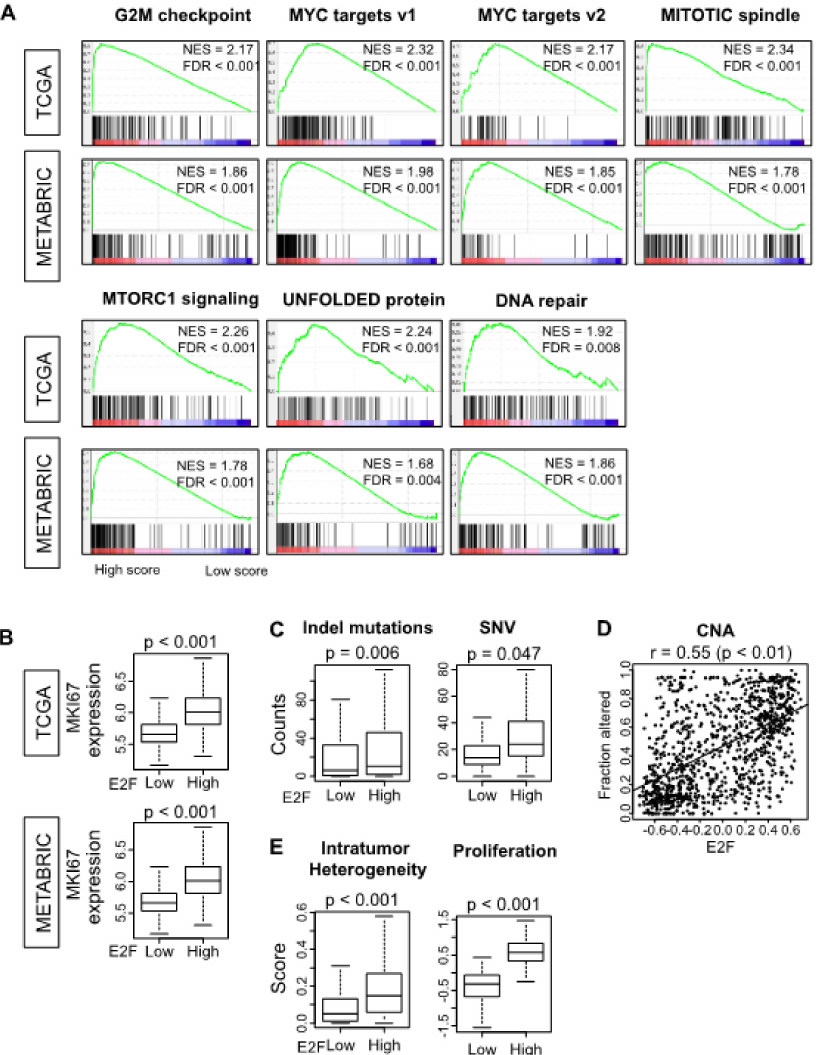
Figure 1. Molecular features of tumors with high and low E2F pathway scores. Within each cohort, the median value of the score is used to divide cohorts into high and low groups. ( A )